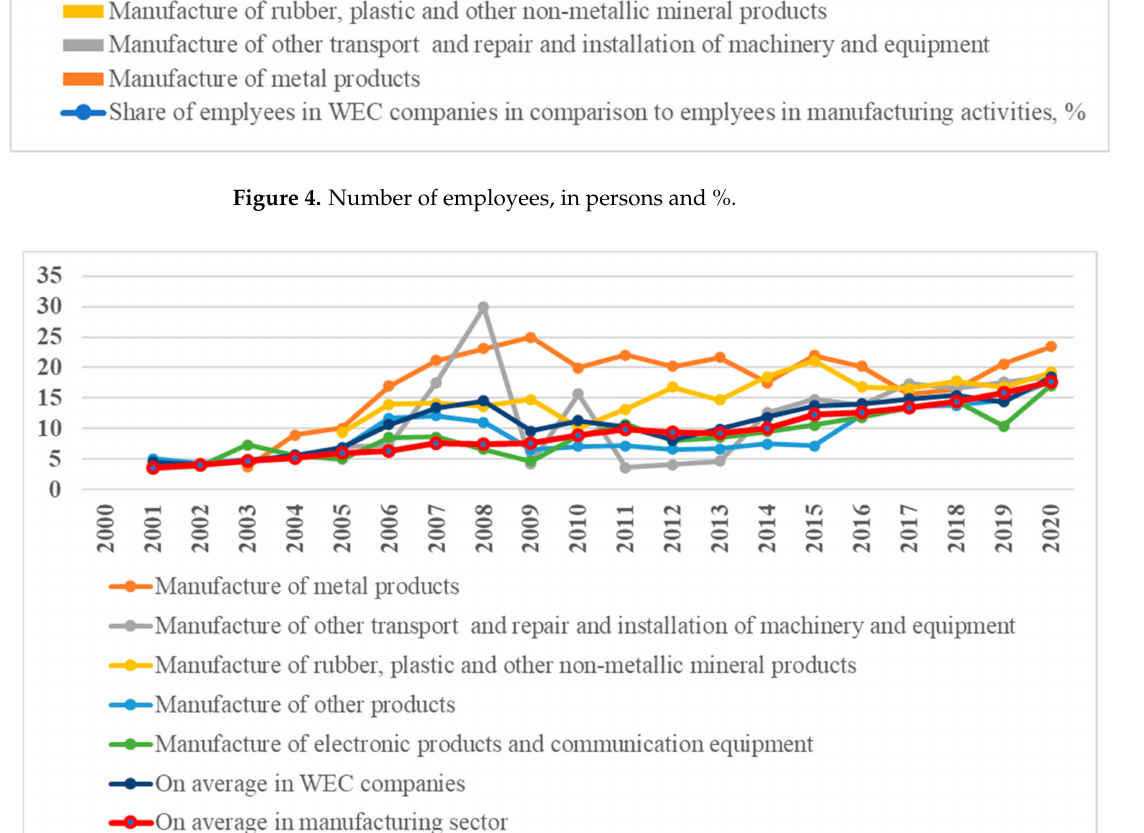
Figure 5. Labour productivity,